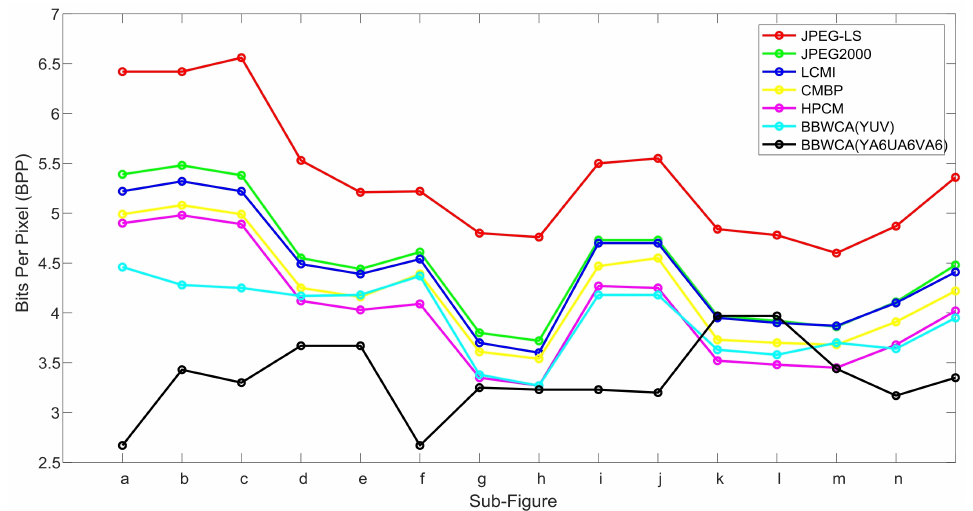
Figure 9. Bits Per Pixel (BPPs) employed by the benchmark and BBWCA for lossless compression of CFA